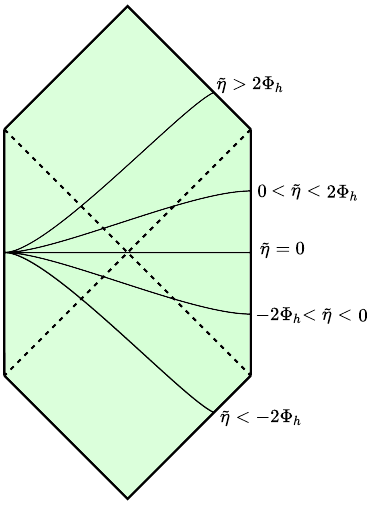
( s ) fired from the left boundary at t − = 0 e t − e η